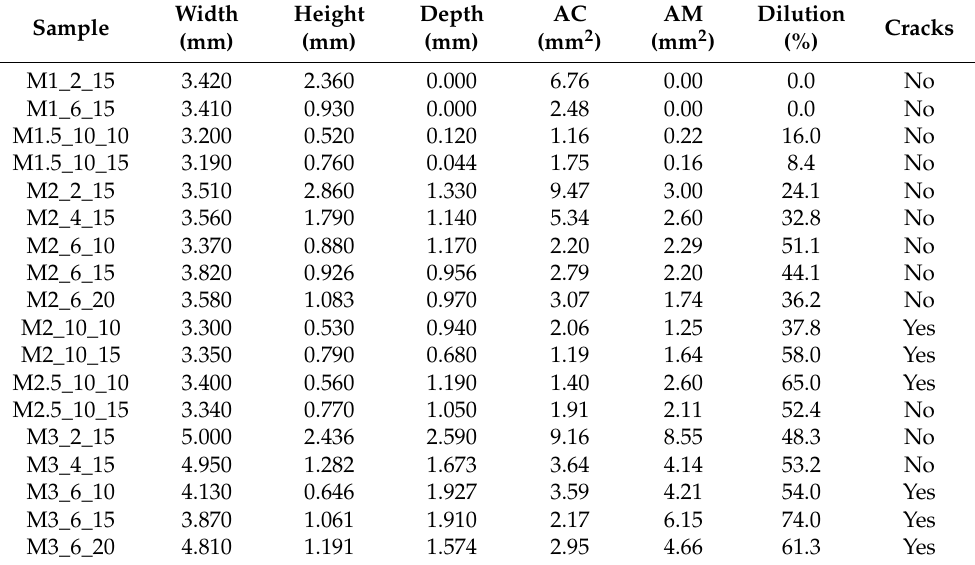
Table 3. Dimensional analysis and dilution of clads produced by DLD without PHT. AC—Clad Area; AM—Melting Area.